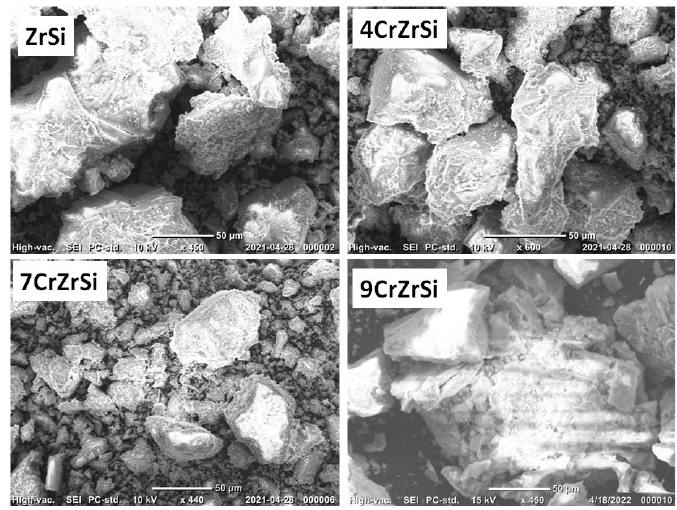
Figure 1. SEM images of fresh ZrSi and CrZrSi catalysts.